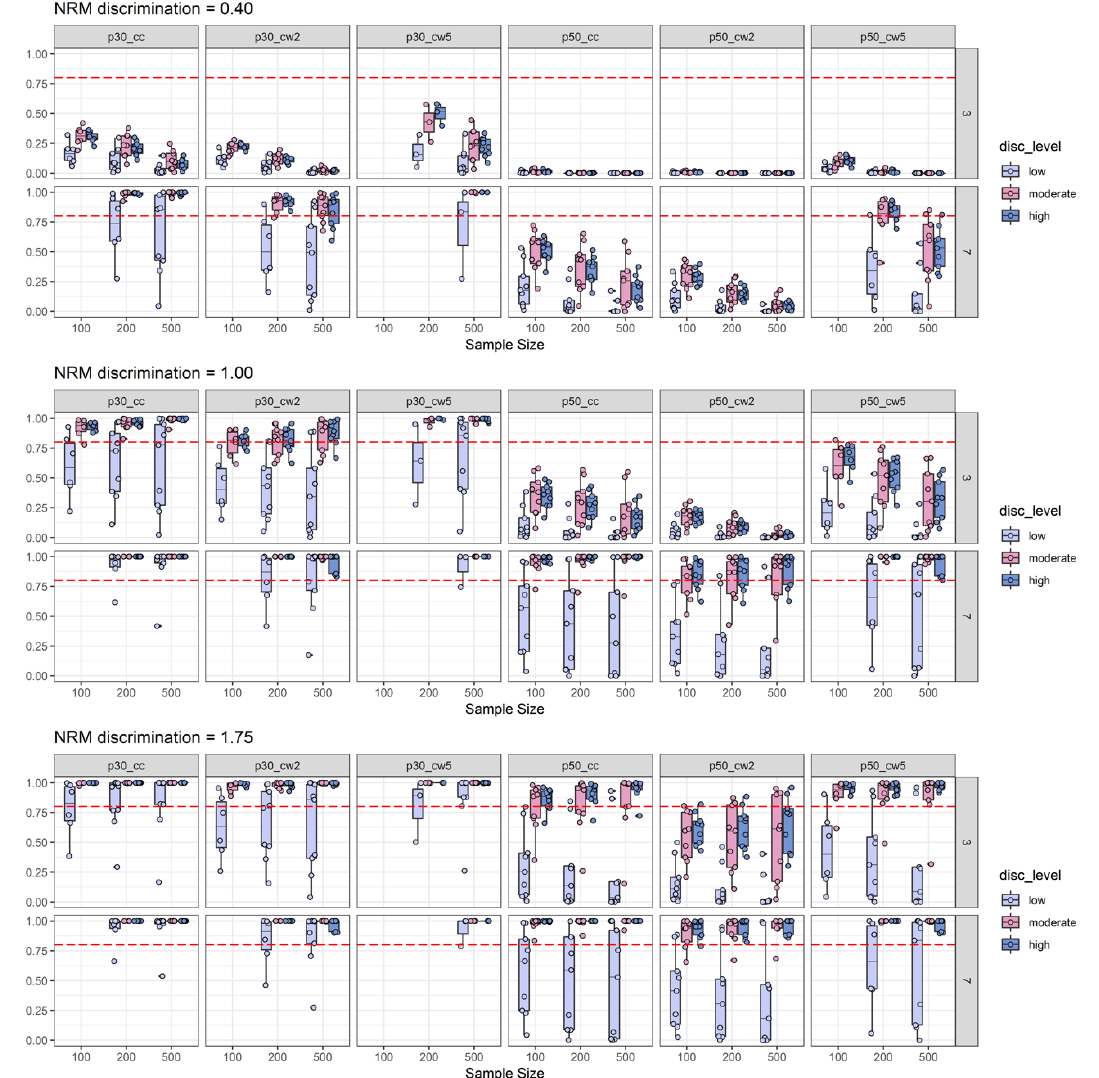
Figure 5. 2PL-discrimination split of empirical power analysis: Depiction of the empirical power (y-axis) as a function of NRM discrimination, sample size (x-axis), number of distractors, 2PL-discrimination (disc_level: Low vs. moderate vs. high), and effect size measures combined with effect size thresholds. The horizontal red dashed line represents the target power level of 0.80. For more explanations, see Figures 2 and 3.